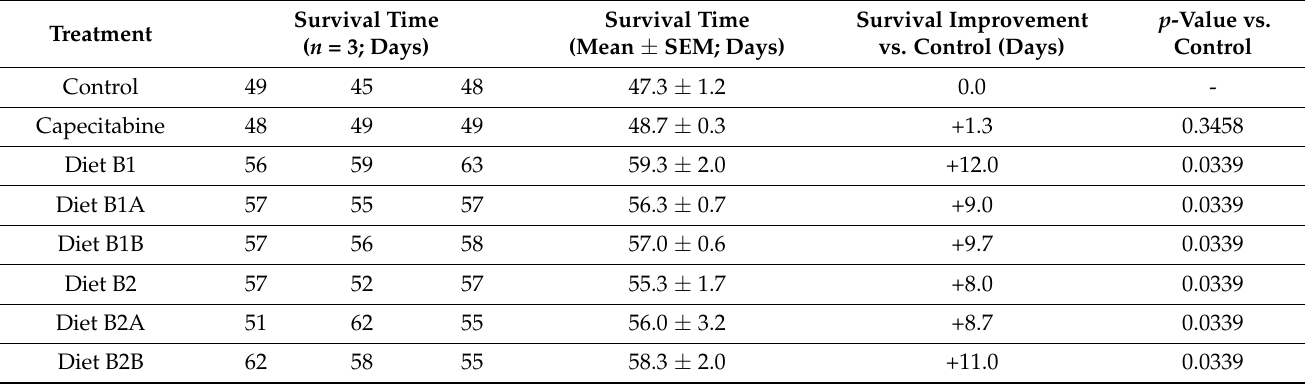
Table 1. Survival of mice with ovarian cancer treated with artificial diets or capecitabine.